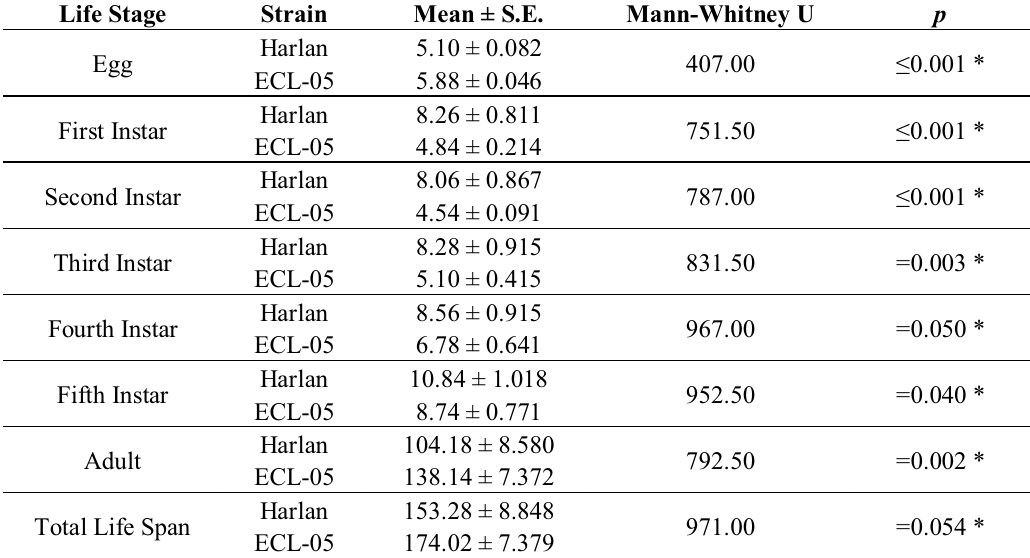
* Indicates significant statistical difference ( p